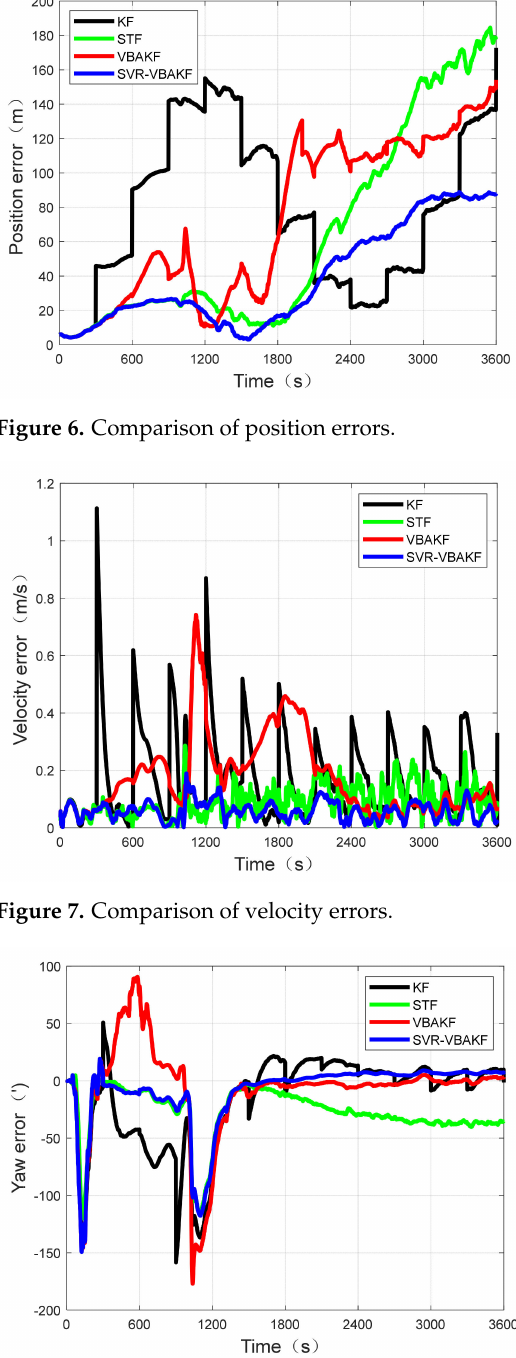
Figure 8. Comparison of Yaw